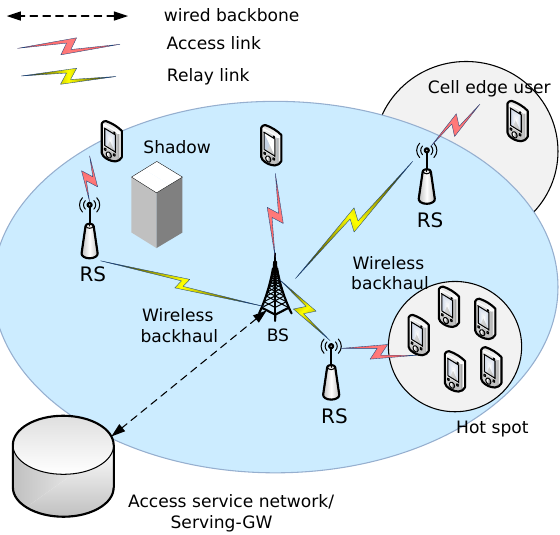
Figure 1. Dual-hop relay